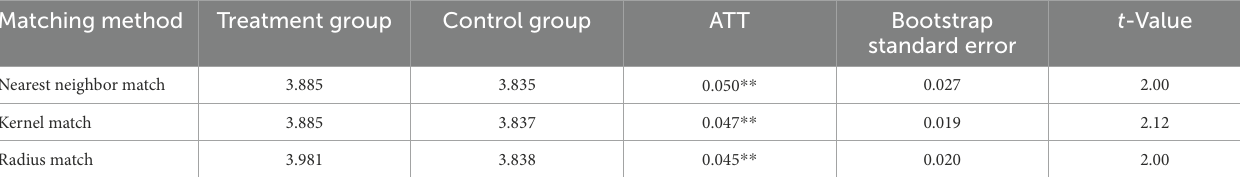
TABLE 5 Average treatment